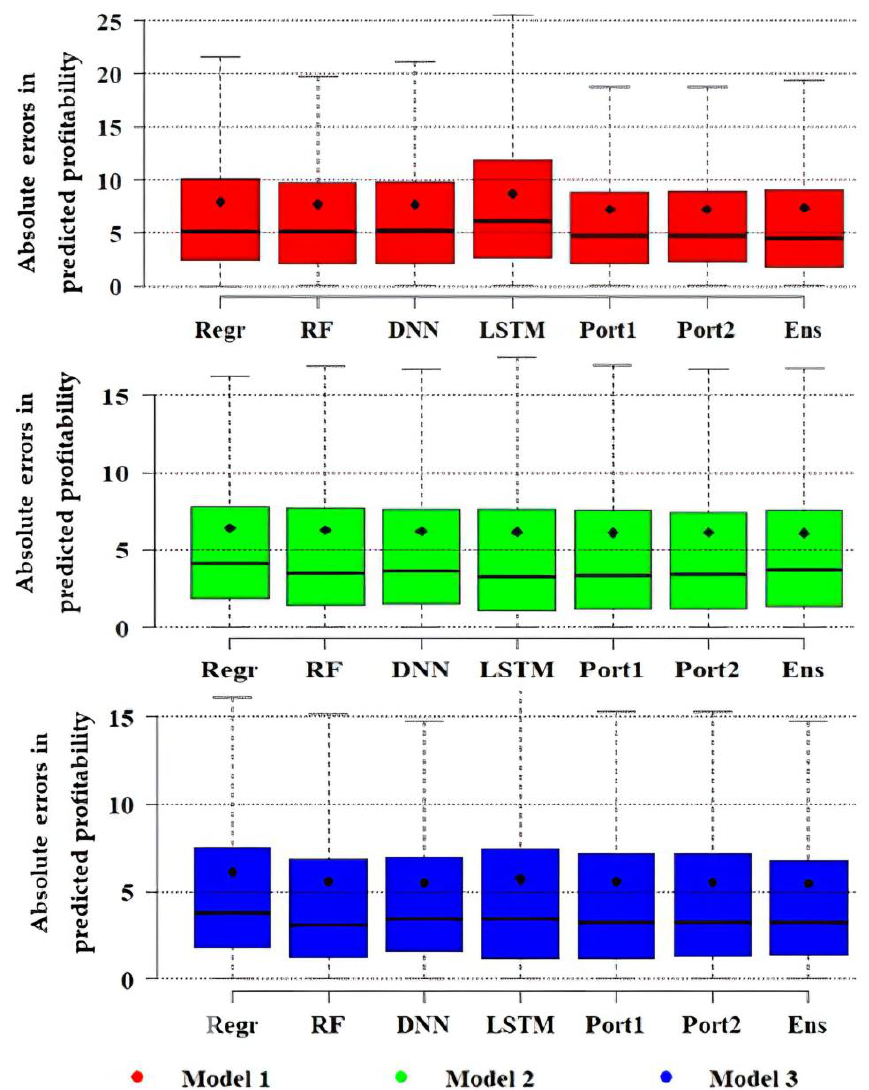
Figure 7. Boxplots of absolute errors for various models and methods for predicting profitability on the test sample. Hereinafter, point—mean value, line—median, rectangle—25–75% quartile range, whiskers—minimum and maximum values or 1.5 interquartile